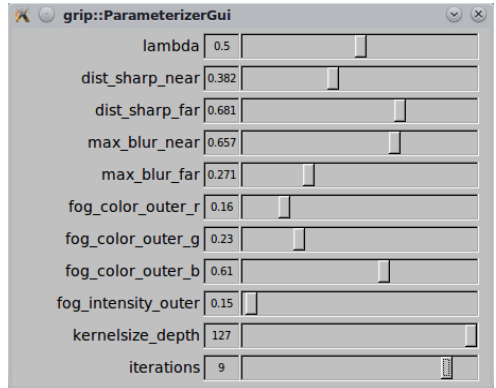
Figure 2. GrIP: Parameters for depth darkening, depth of field and fog in a single parameterizer GUI